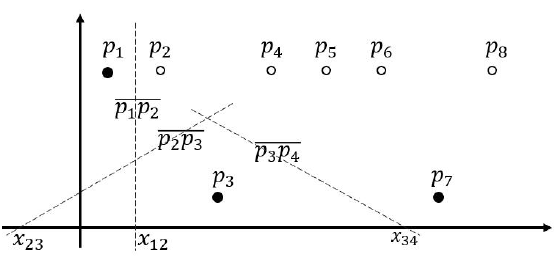
Figure 9. An Example of Step